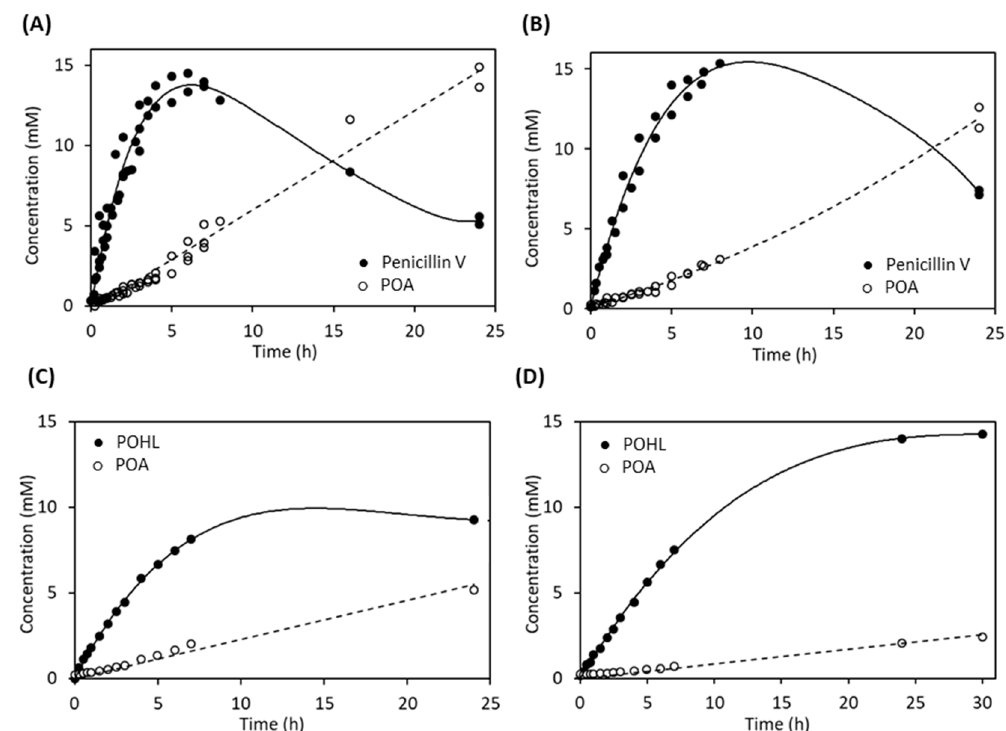
Figure 5. Synthetic activity of Au AHLA. Enzymatic synthesis of penicillin V catalyzed by Au AHLA in the presence of 3% ( A ) and 32% ( v/v ) DMSO ( B ) as co-solvent. Enzymatic synthesis of POHL catalyzed by Au AHLA in the presence of 23% ( C ) and 50% ( v/v ) DMSO ( D ) as co-solvent. Reaction conditions: 1 IU/mL Au AHLA, 0.1 M potassium phosphate pH 7.0 buffer, 100 mM acyl acceptor (6-APA or HSL), 20 mM MPOA and 30 °C. Table 2. Parameters for the kinetically controlled synthesis of penicillin V and POHL catalyzed by Au AHLA. Product Au AHLA (IU/mL) DMSO (%) 0.125 0.125 Penicillin V Penicillin V 1 MPOA.